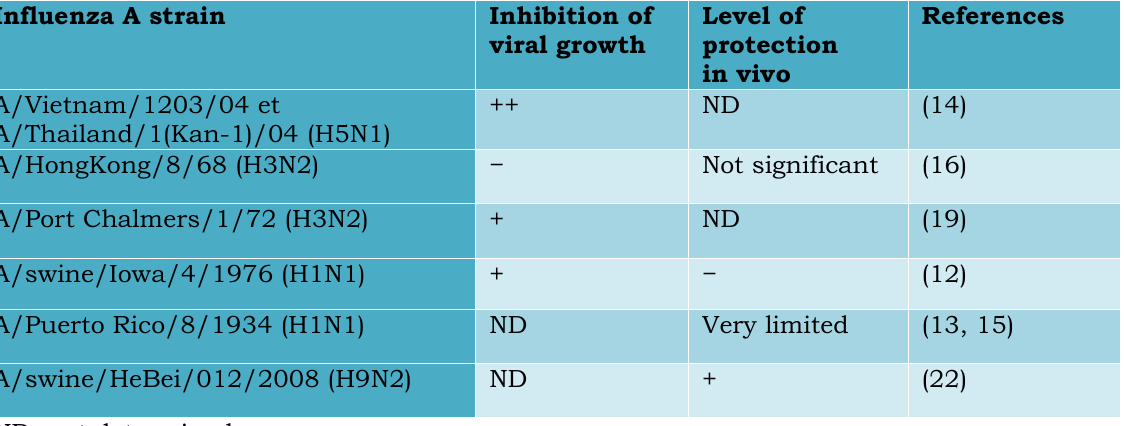
Table 1. Effect of N-acetylcysteine treatment on viral growth and protection of infected mice for several influenza A strains Influenza A strain Inhibition of